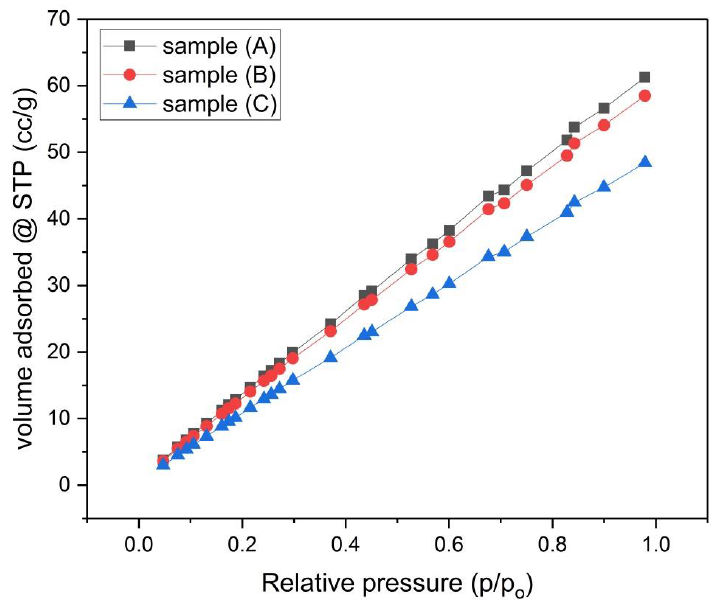
Figure 6. N 2 Adsorption Isotherms for samples (A), (B) and (C).